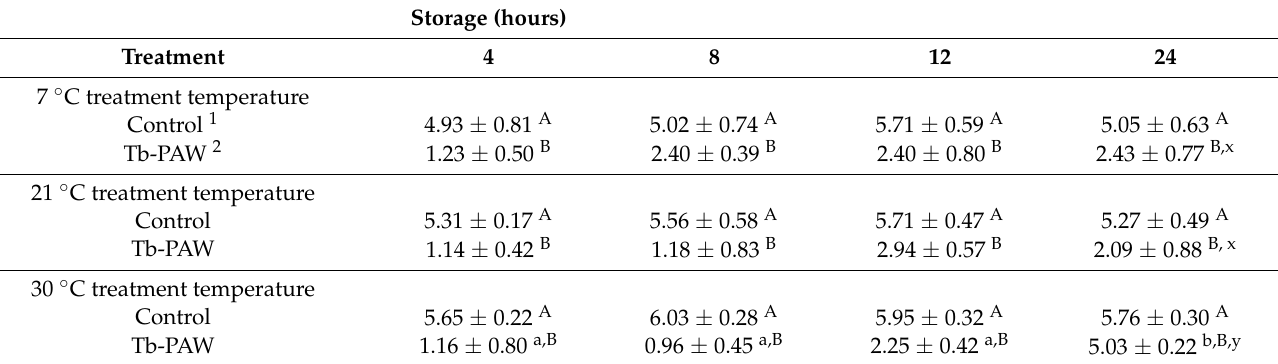
Table 1. Means and standard deviation of E. coli counts (log CFU/mL) following 1 min Tb-PAW